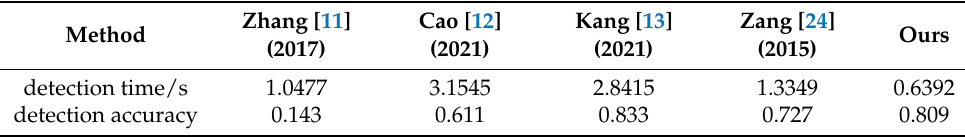
(17) Table 1. Comparison of evaluation results. Method